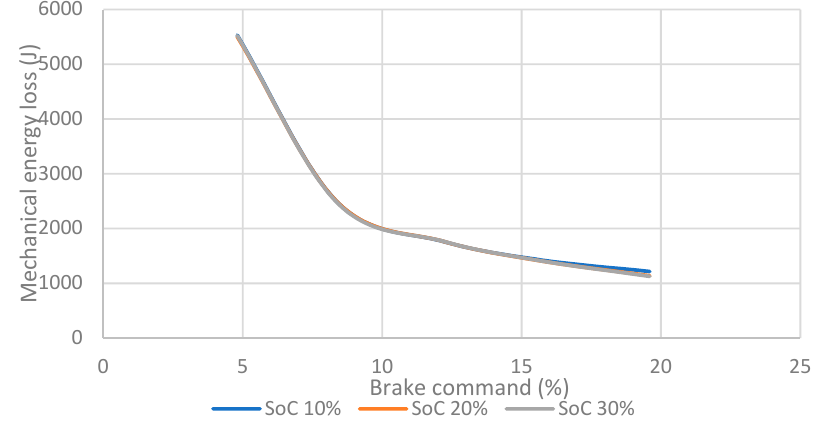
Figure 9. Mechanical losses vs. brake command.